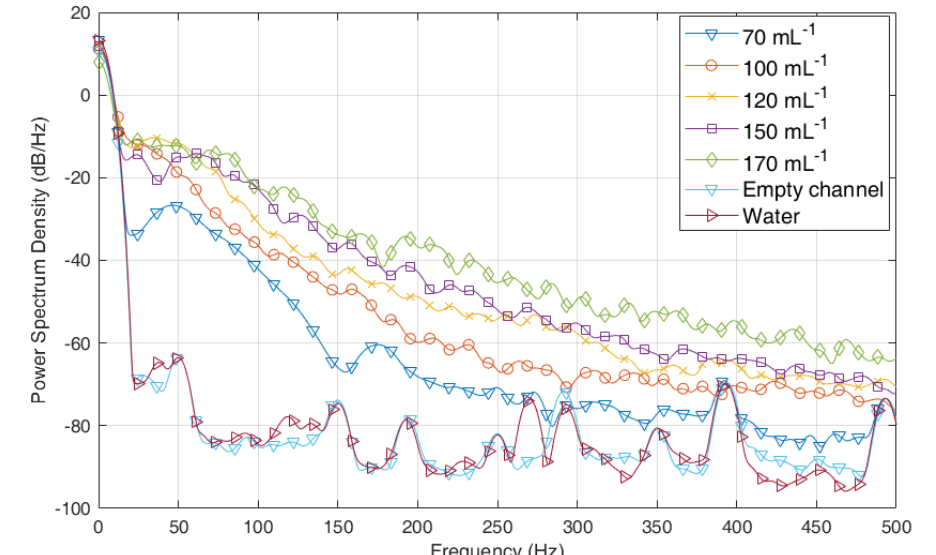
Figure 4. Power Spectral Density of the optical signals in decibels.